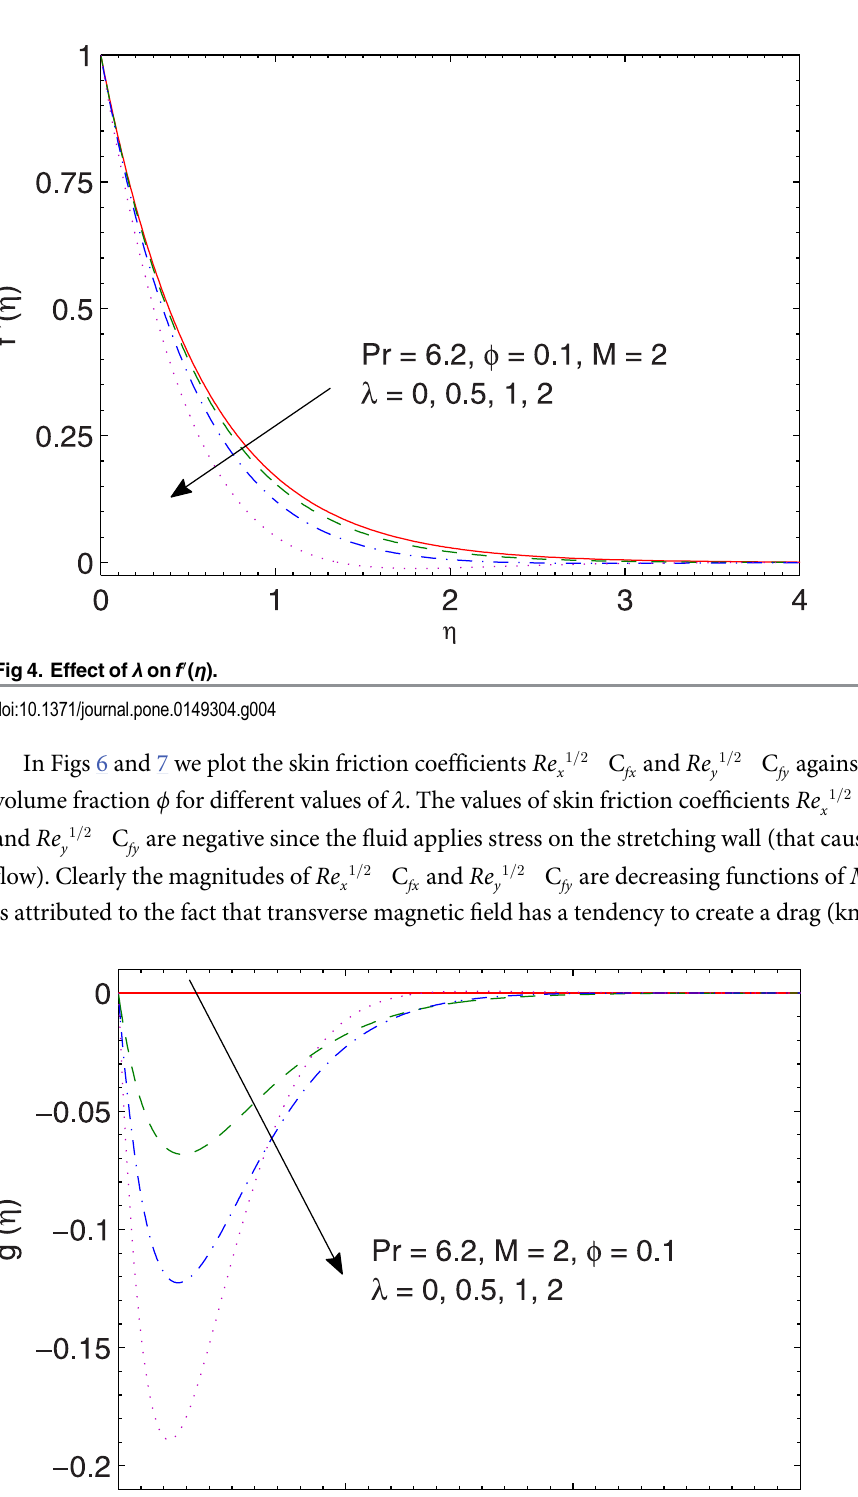
Fig 5. Effect of λ on g ( η